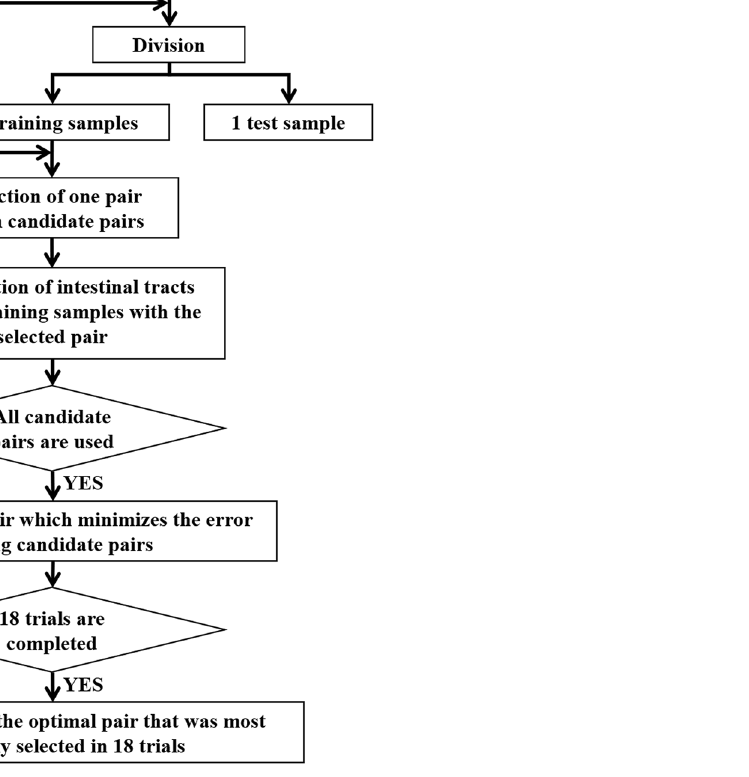
Figure 7. Scheme of optimization of threshold